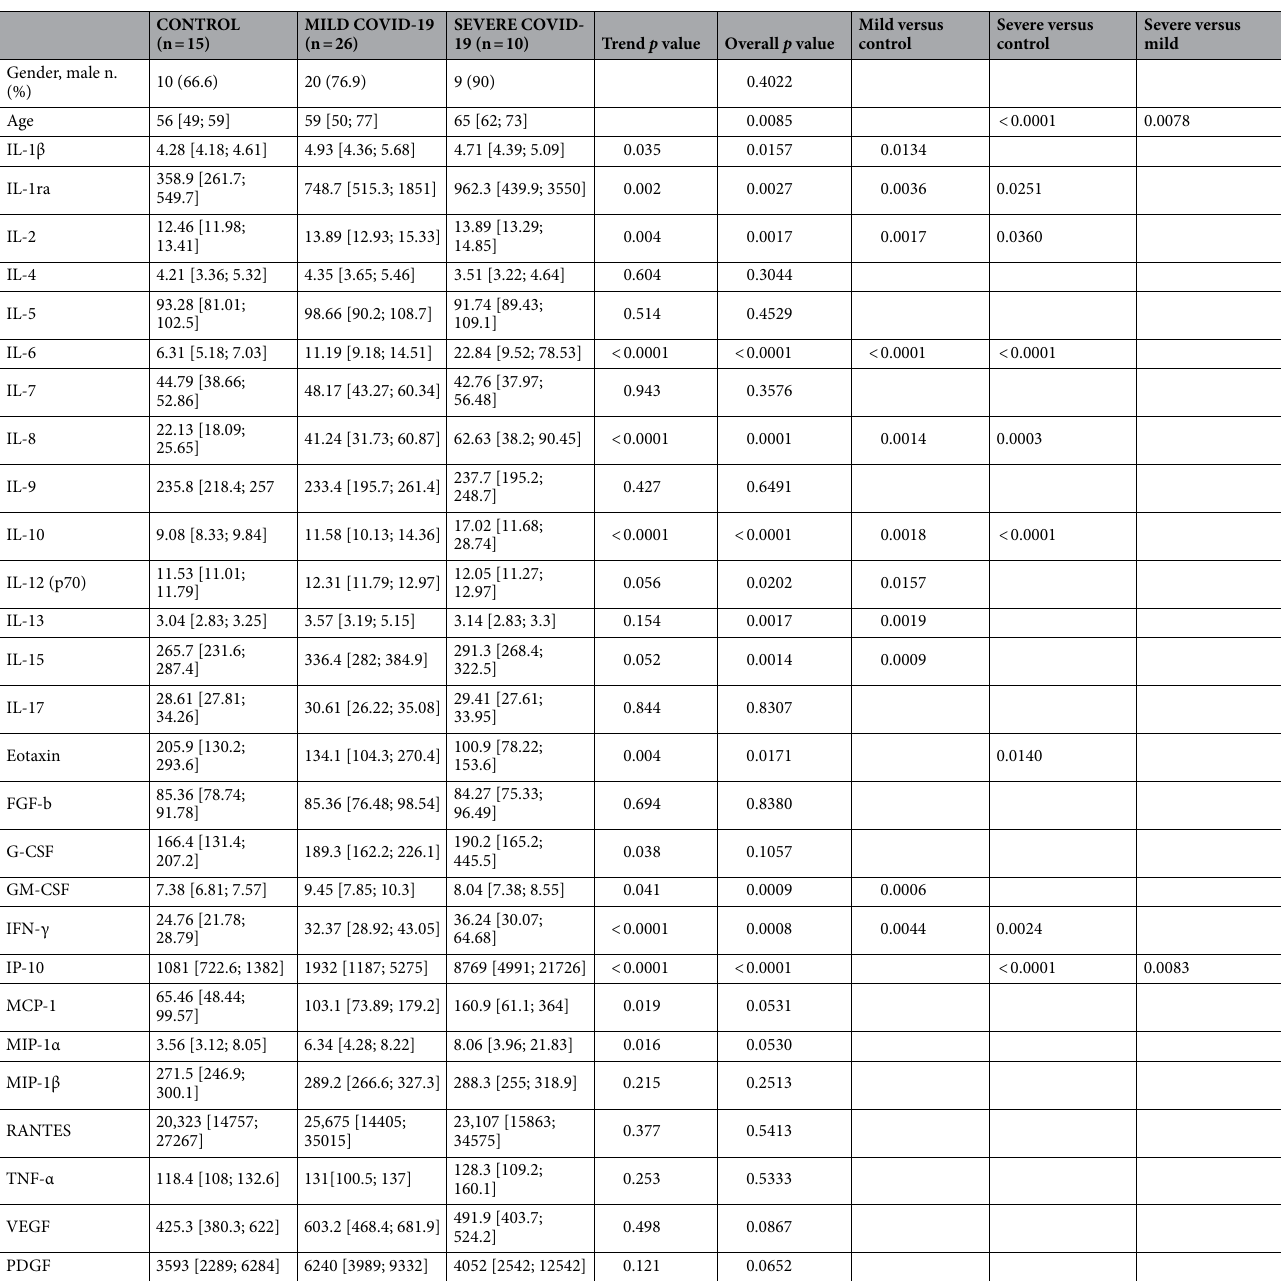
Table 2. Serum concentration (pg/ml) of cytokines, chemokines and growth factors (Wave 2). Results are expressed as median and range [25% percentile; 75% percentile] or number of cases (%). Jonckheere–Terpstra test was used to assess the trend between groups. The non parametric Kruskall Wallis test was applied to assess the difference among three groups followed by Mann Whitney U test for pairwise